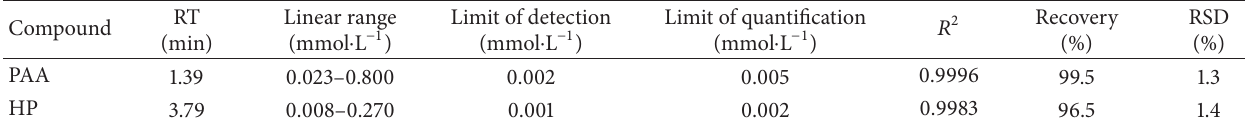
Table 1: Analytical characteristics of the validated